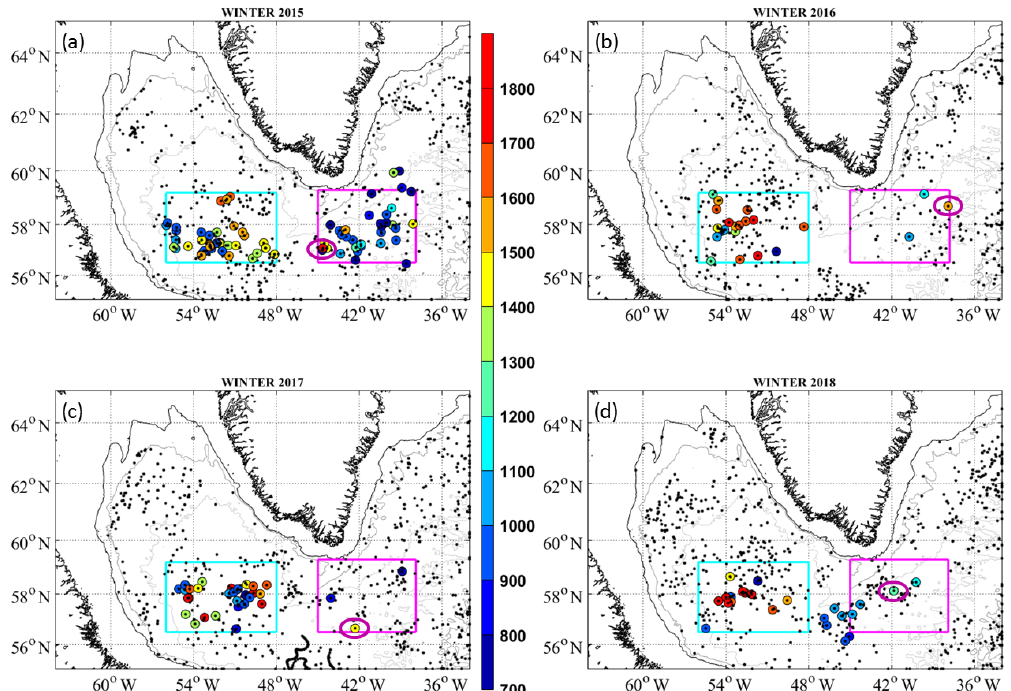
Figure 1. Positions of all Argo floats north of 55 ◦ N in the Atlantic between 1 January and 30 April (a) 2015, (b) 2016, (c) 2017 and (d) 2018 (black and colored points). The colored points and color bar indicate the mixed layer depth (MLD) when the MLD was deeper than 700m. The pink circles indicate the position of the maximal MLD observed SECF each winter. The pink and cyan boxes delimit the regions used for estimating the time series of atmospheric forcing and the vertical profiles of buoyancy to be removed in the SECF region and the Labrador Sea, respectively (SECF: 56.5–59.3 ◦ N and 45.0–38.0 ◦ W, Labrador Sea: 56.5–59.2 ◦ N and 56–48 ◦